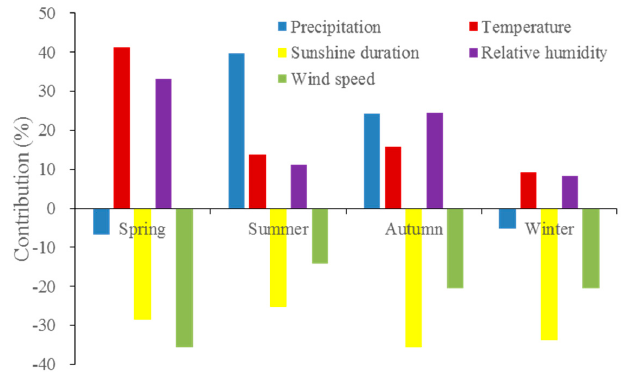
Figure 6. Contribution of each climatic factor to the seasonal R changes in the HTRB.